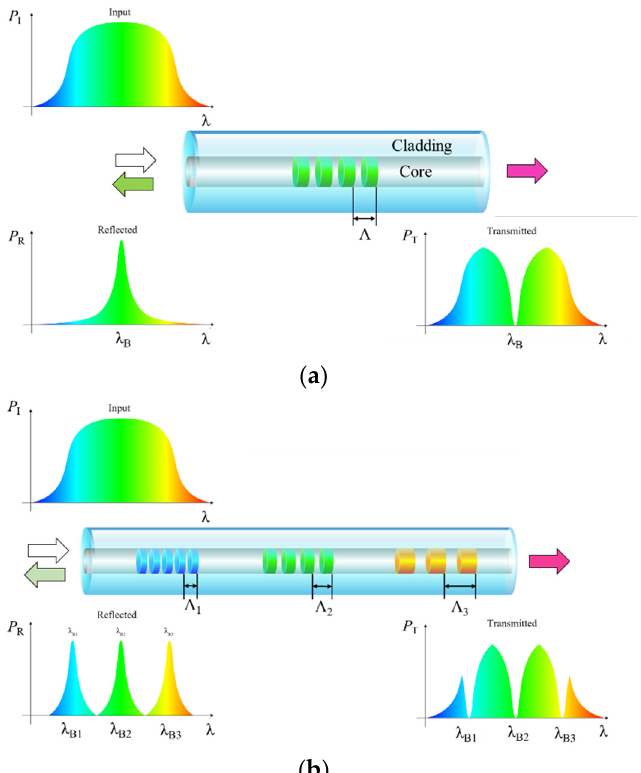
Figure 11. Schematic of ( a ) one fiber Bragg grating (FBG) and optical spectral responses [47] and ( b ) multiple FBG structures along an optical fiber and optical spectral responses [48].